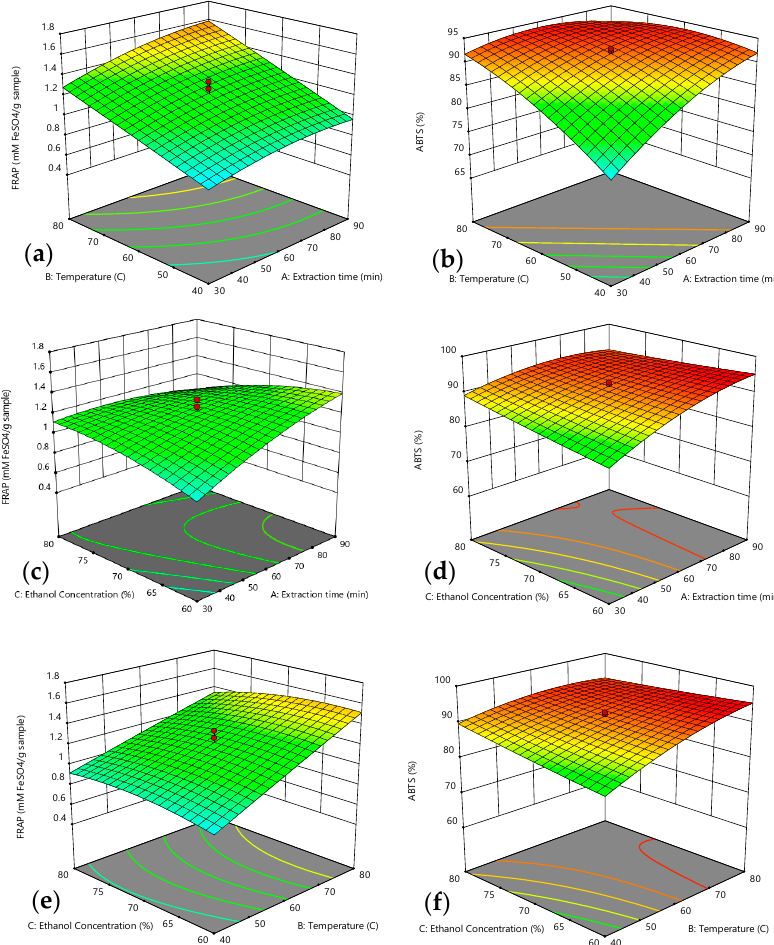
Figure 2. Response surface for: ( a , b ): e ff ect of extraction time and temperature; ( c , d ): e ff ect of extraction time and ethanol concentration; and ( e , f ): e ff ect of temperature and ethanol concentration, on FRAP ( a , c , e ) and ABTS ( b , d , f )